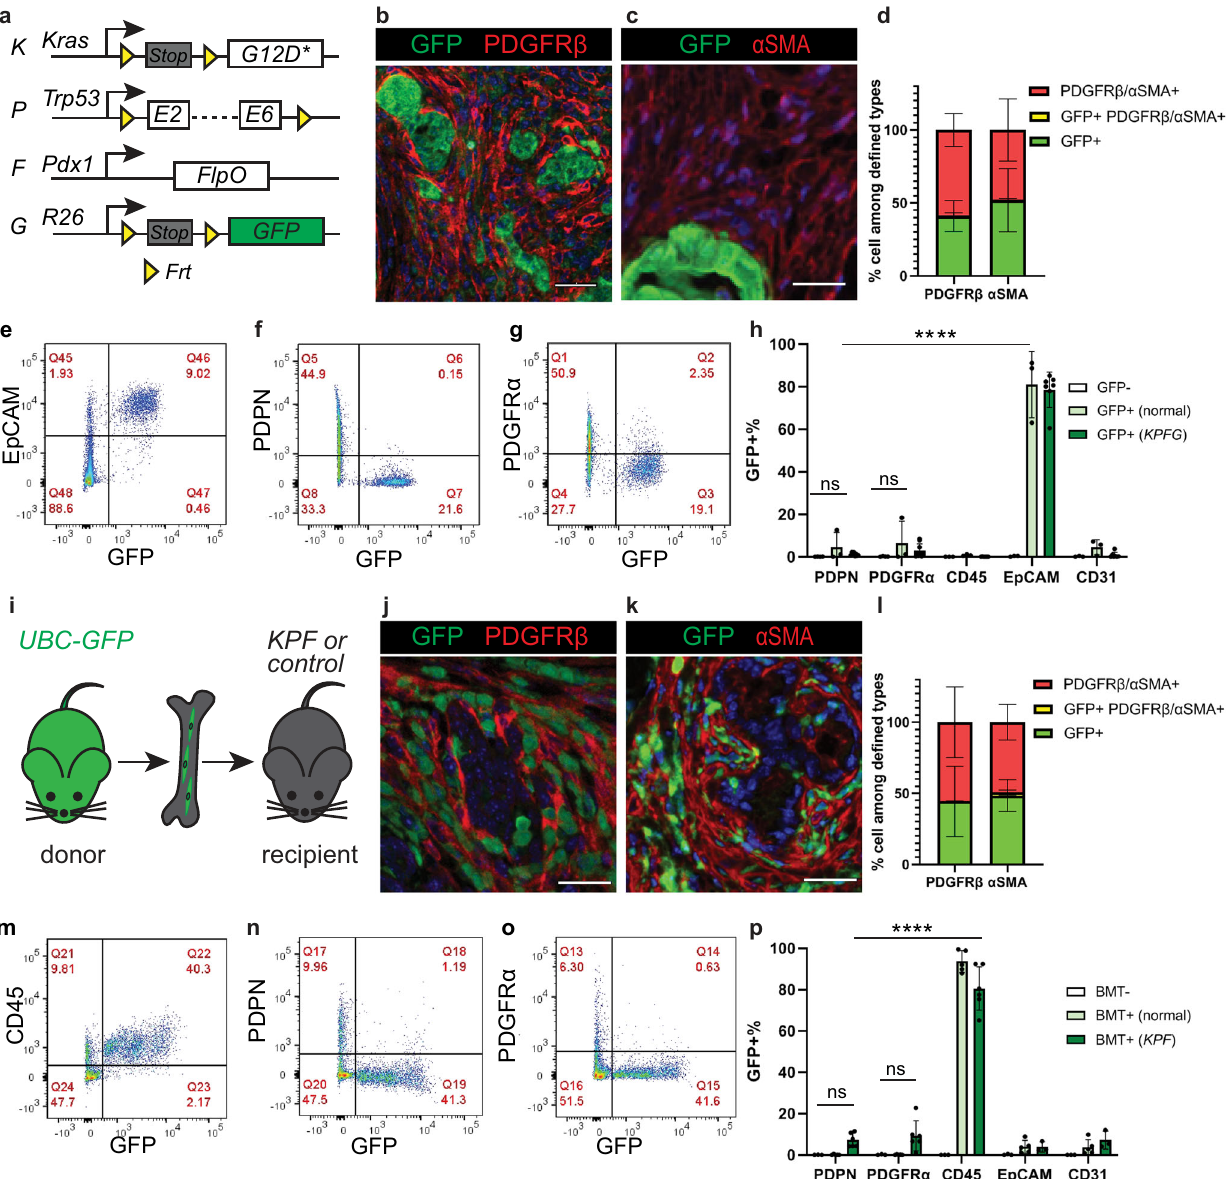
Fig.1|Epitheliumandbonemarrowminimallycontributetopancreaticcancer associated fi broblasts. a Schematic of the KPFG mouse model. b – d Co- immunostaining in the KPFG pancreas and quanti fi cation of cells that are either single positive or double positive for de fi ned markers. n =7 mice for PDGFR β ana- lysis; n =8micefor α SMAanalysis. e – h Flow cytometryanalysisof dissociated KPFG pancreas and quanti fi cation of GFP+cells within populations de fi ned by markers. n =4 mice for GFP-; n =3 mice for GFP+(normal); n =9 mice for GFP+( KPFG ). **** p <0.0001; ns for PDPN: p =0.996; ns for PDGFR α : p =0.923. i Schemat i c of the bonemarrowtransplant(BMT)experiment. j – l Co-immunostaining inKPFpancreas